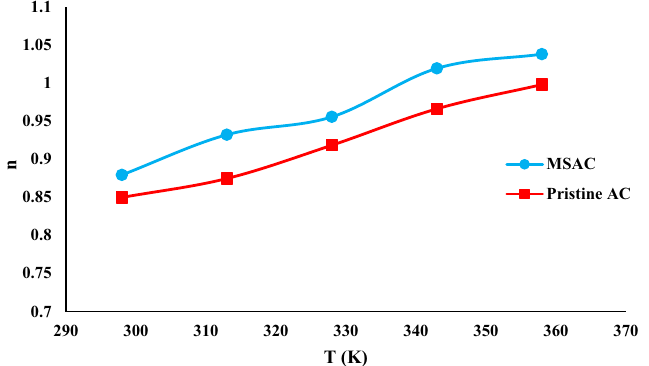
Figure 8. Change in n parameter with the variation of temperature for MSAC and pristine AC.